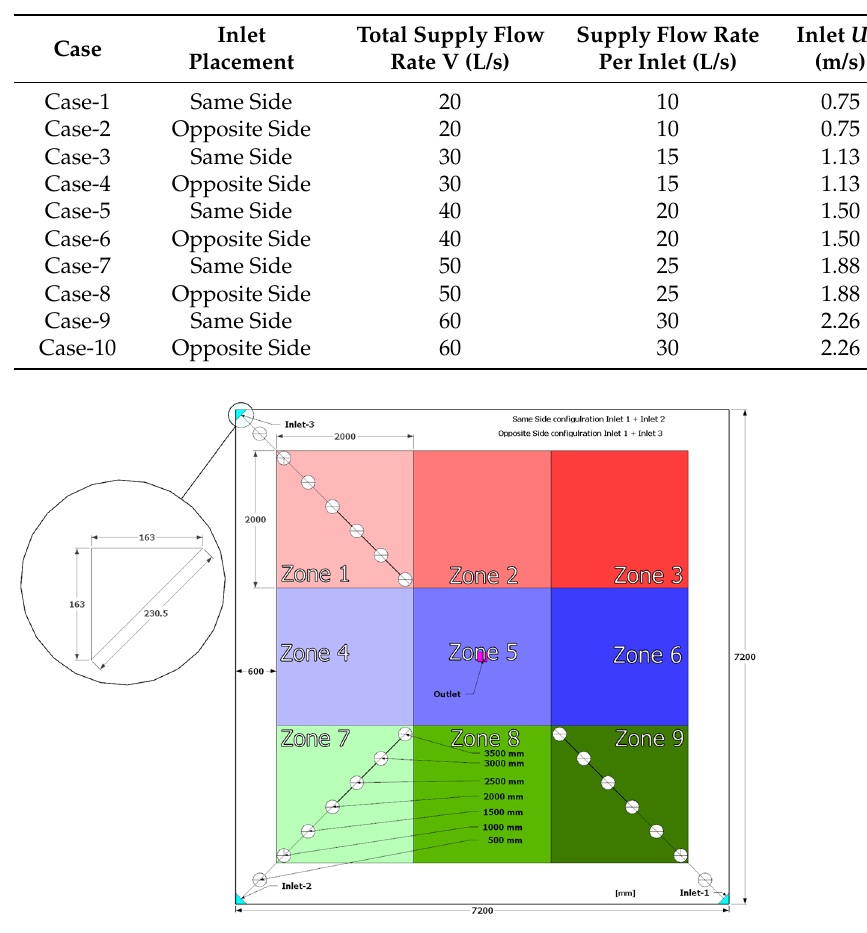
Figure 2. The layout of the measurement positions and their distance to each corner part of the room. The figure also shows regions of interest in the form of zones 1–9. On the left side, a zoomed-in picture of the inlet is shown with its